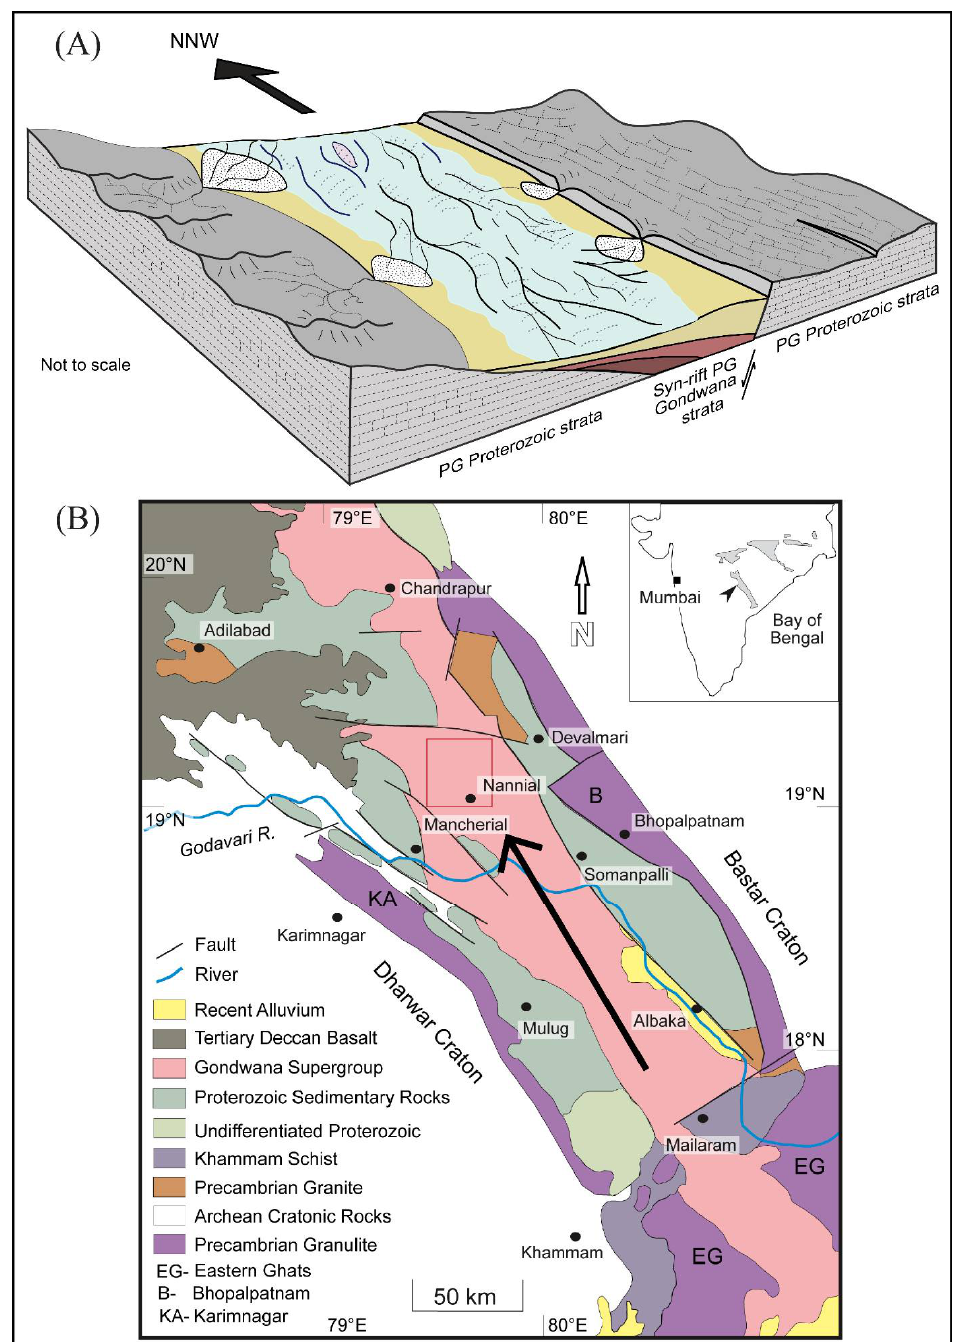
Figure 11. ( A ) Schematic diagram showing the Middle Triassic–Early Jurassic paleogeography of the Pranhita-Godavari (PG) Gondwana basin, indicating the dominance of the axial drainage system (arrow), along with a few transverse drainages (locally occurring along alluvial fans) on either side that persisted during the Mesozoic era. ( B ) Black arrow indicates the inferred paleoslope (parallel to the axial drainage system shown in ‘A’) in the geological map showing the exposure belt of the Gondwana supergroup of the Pranhita-Godavari rift basin, India, flanked on either side by the Precambrian rocks (adapted from [31]). The paleocurrent direction indicates most of the detritus were transported from the highs located in the S-SE direction with respect to the Gondwana basin along the axial drainage system. The study area is marked by a rectangle, which corroborates with the study area shown in Figure 1A.